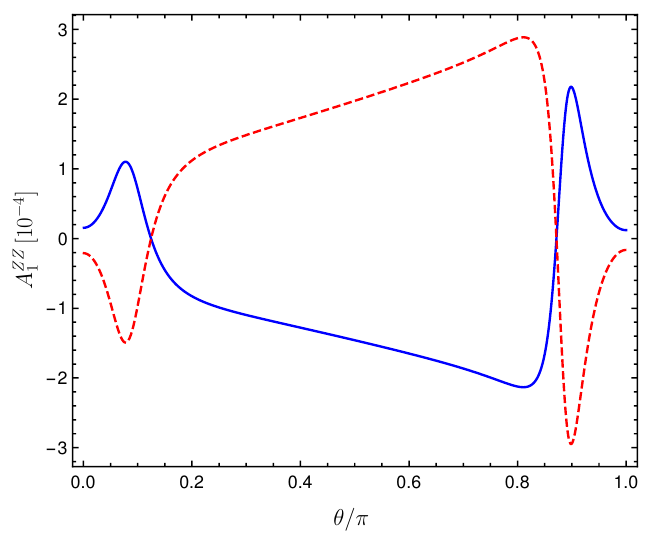
Figure 7. The A ZZ asymmetry of eq. (4.9) as a function of the angle (cid:18) . The blue (full) curve 1 corresponds to the largest positive value of Im one to the smallest negative value for the same quantity. In both cases, p 2